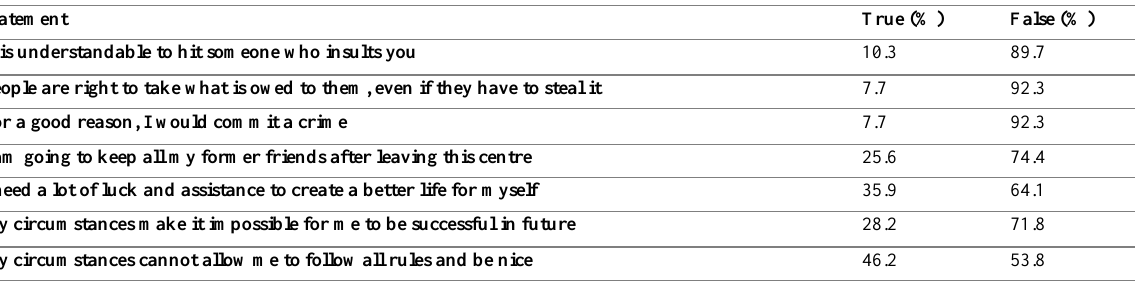
Table 2: Children Attitude towards Crime and